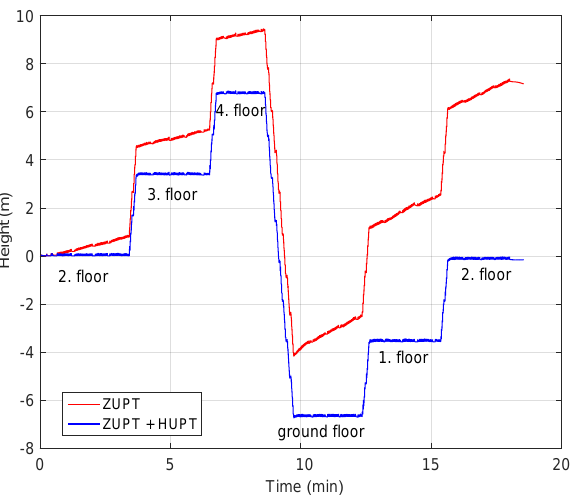
Figure 8. Height estimation corresponding to the walk of one of the volunteers over five floors. The red curve has been computed applying only ZUPT corrections, while the blue curve has been computed applying ZUPT corrections and the proposed HUPT correction.